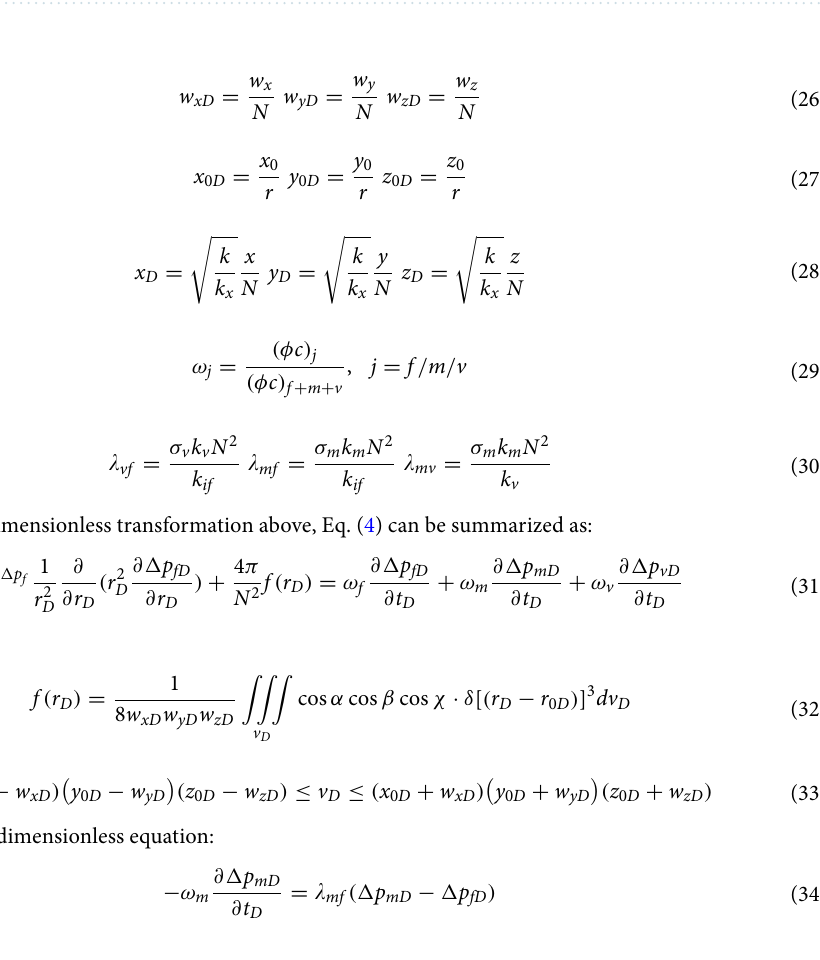
Figure 17. The effect of permeability modulus on type